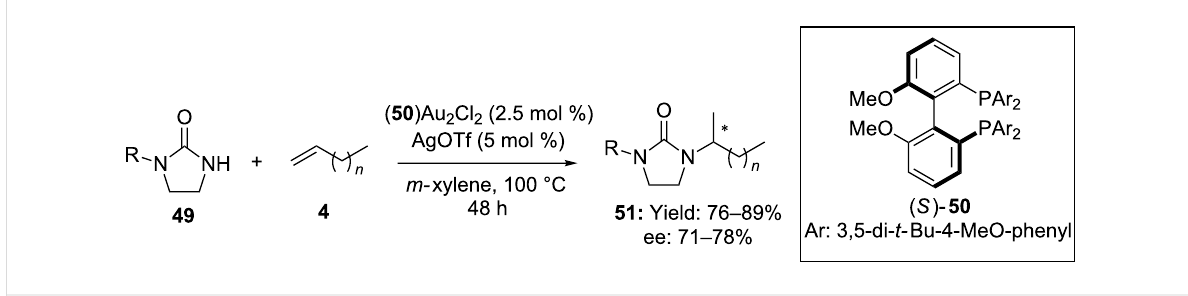
Table 2: Cooperative [Au(I)]/menthol catalysis for the enantioselective intramolecular hydroamination of dienes.